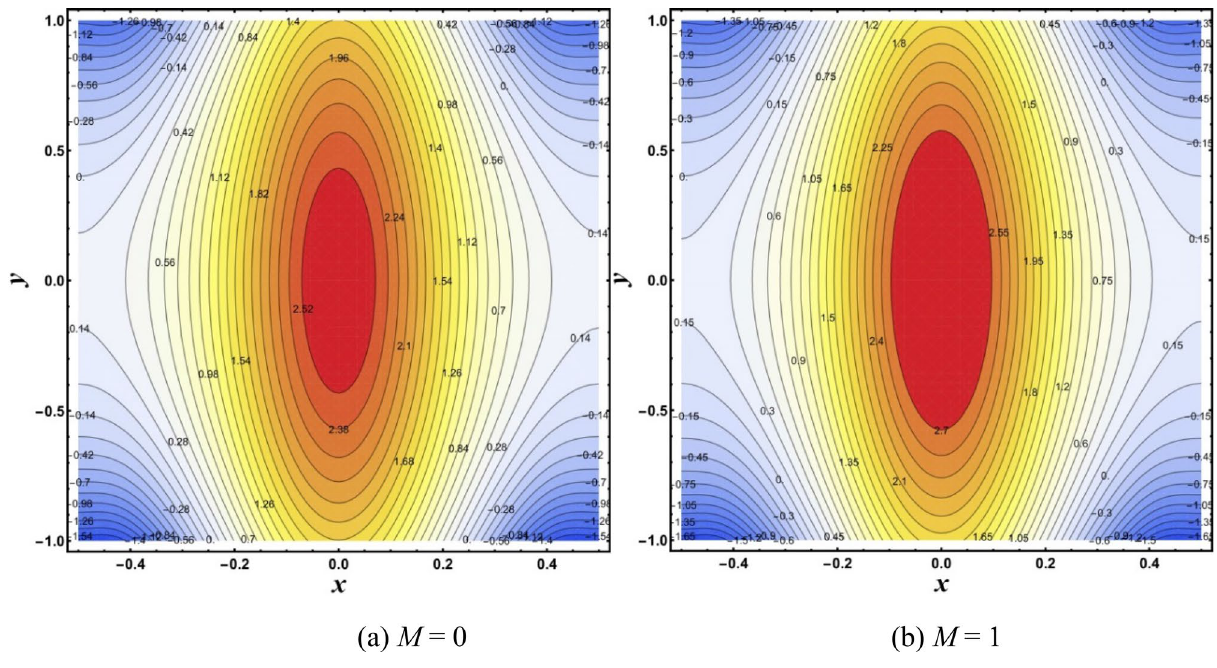
Figure 5. Isotherms for change in M .